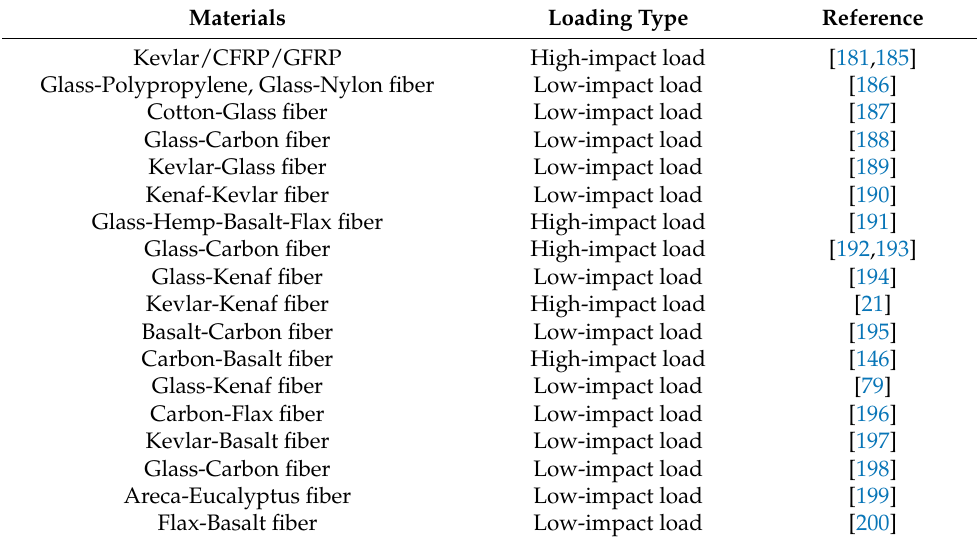
Table 2. Reported studies on the experimental tests of the low- and high-impact velocity for hybrid FRP